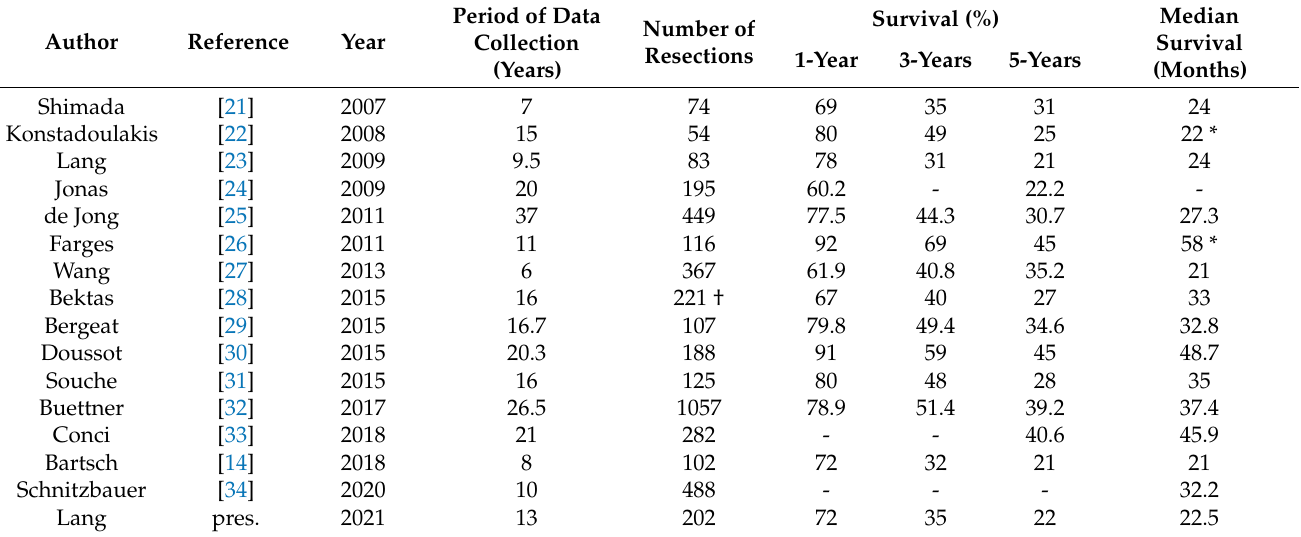
Table 8. Review of the literature—survival after liver resection for